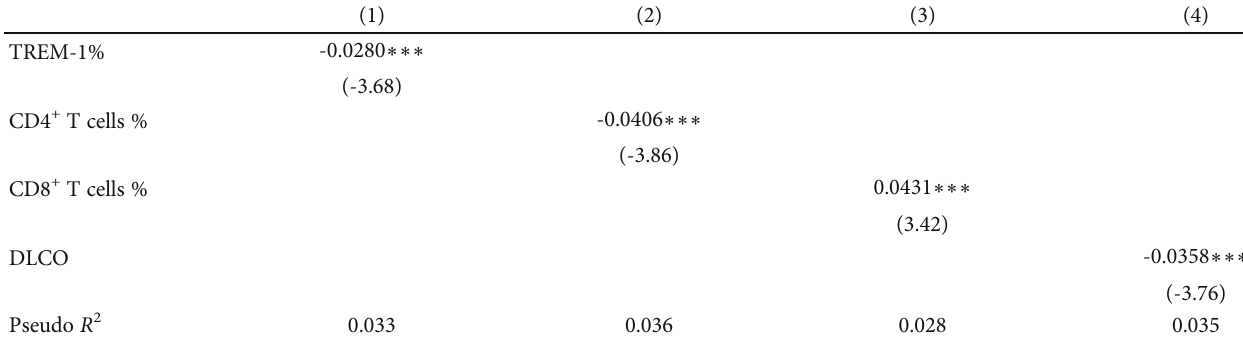
Table 6: Multinomial ordered logit models with dependent variable